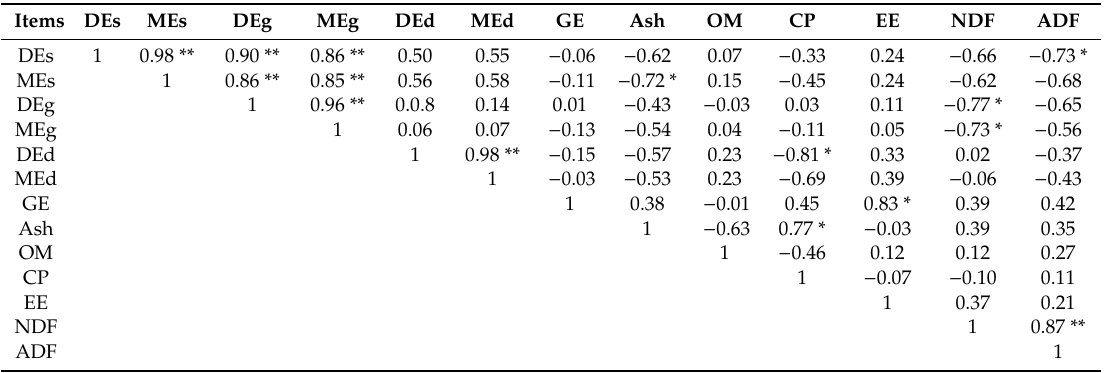
Table 7. Correlation coe ffi cients among chemical characteristics and energy contents of 8 ingredients 1, 2 (dry matter basis).